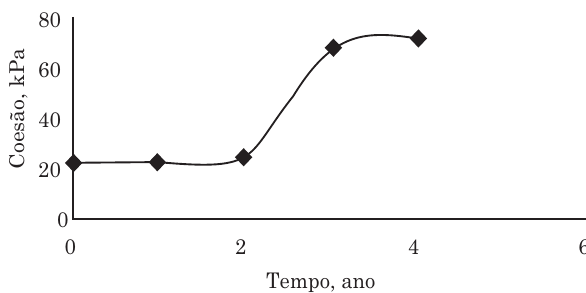
Figura 2. Variação do intercepto de coesão ao longo do tempo de plantio do capim vetiver.